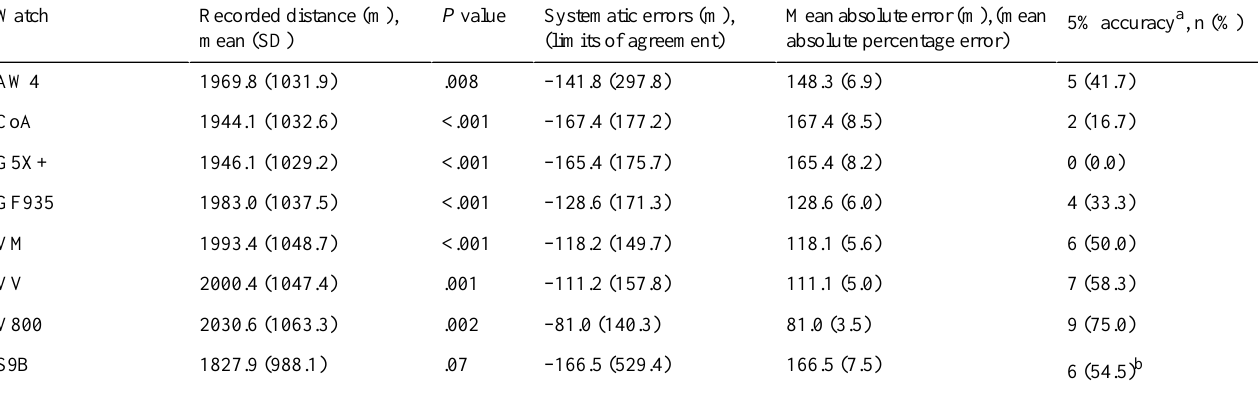
Table 3. Recorded distances and error rates of the eight sport watches obtained in the forest area when compared with the mean reference distance of 2111.6 (SD 1109.9) m (n=12).